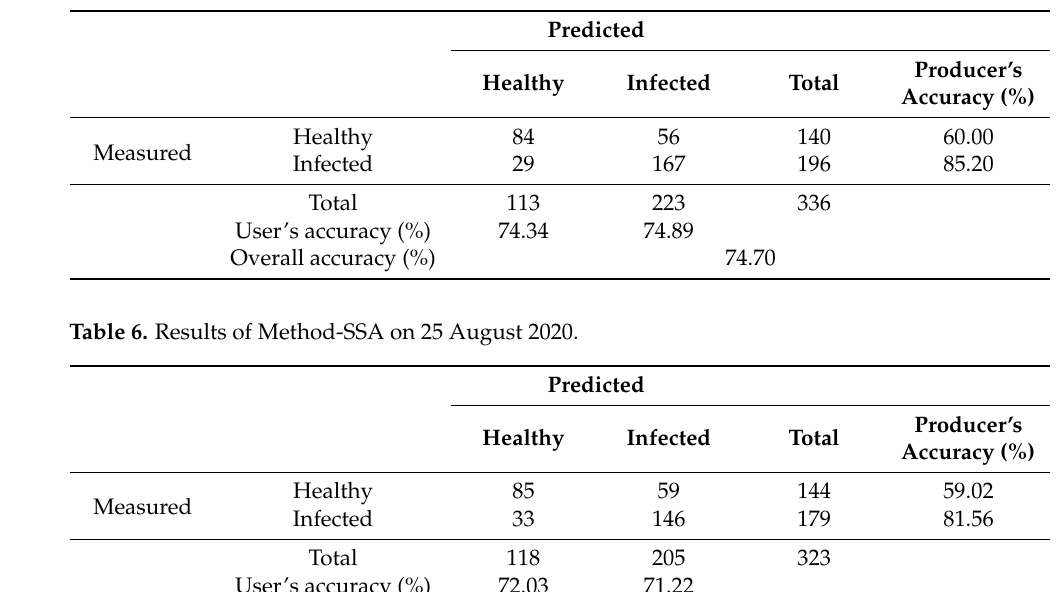
Table 5. Results of Method-SSA on 20 August 2020.